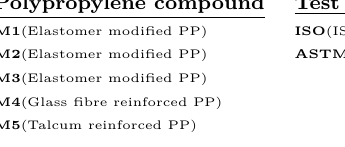
Table 2. Nomenclature of test series.